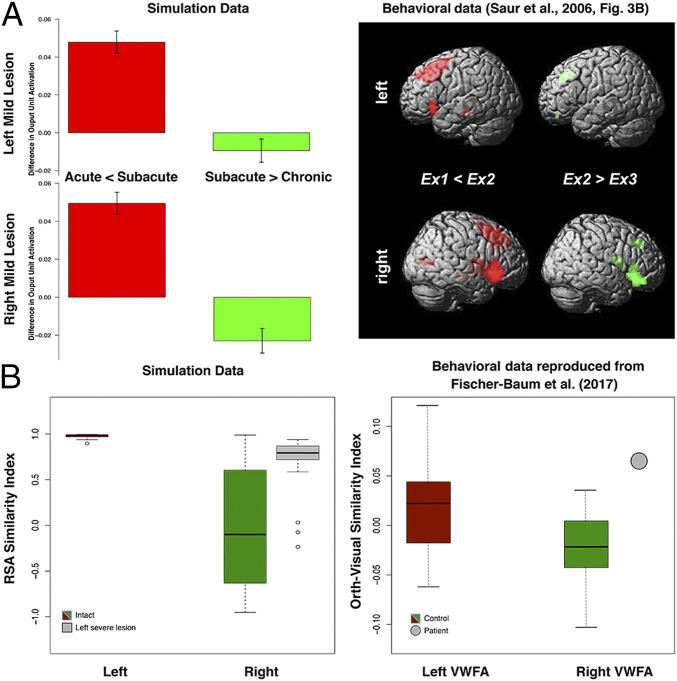
(A) The increment and decrement of the activations in the model with a left mild lesion. Direct comparisons of output unit activations between the acute (300 K to 301 K) and subacute (301 K to 305 K) phases and between the subacute and chronic (305 K to 340 K) phases with the fMRI data of up-regulation and down-regulation in the language network reported by Saur et al. (50). Ex1, acute; Ex2, subacute; Ex3, chronic. (B) RSA similarity indices of the left hidden layer 1 for both the intact model and the model with a severe left lesion. The orth-visual similarity indices for both the controls and the patient in the left VWFA and the right VWFA are from Fischer-Baum et al. (71).